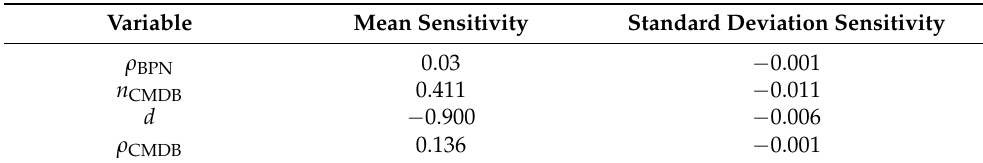
Table 6. Sensitivity results for the pyrotechnic igniter.